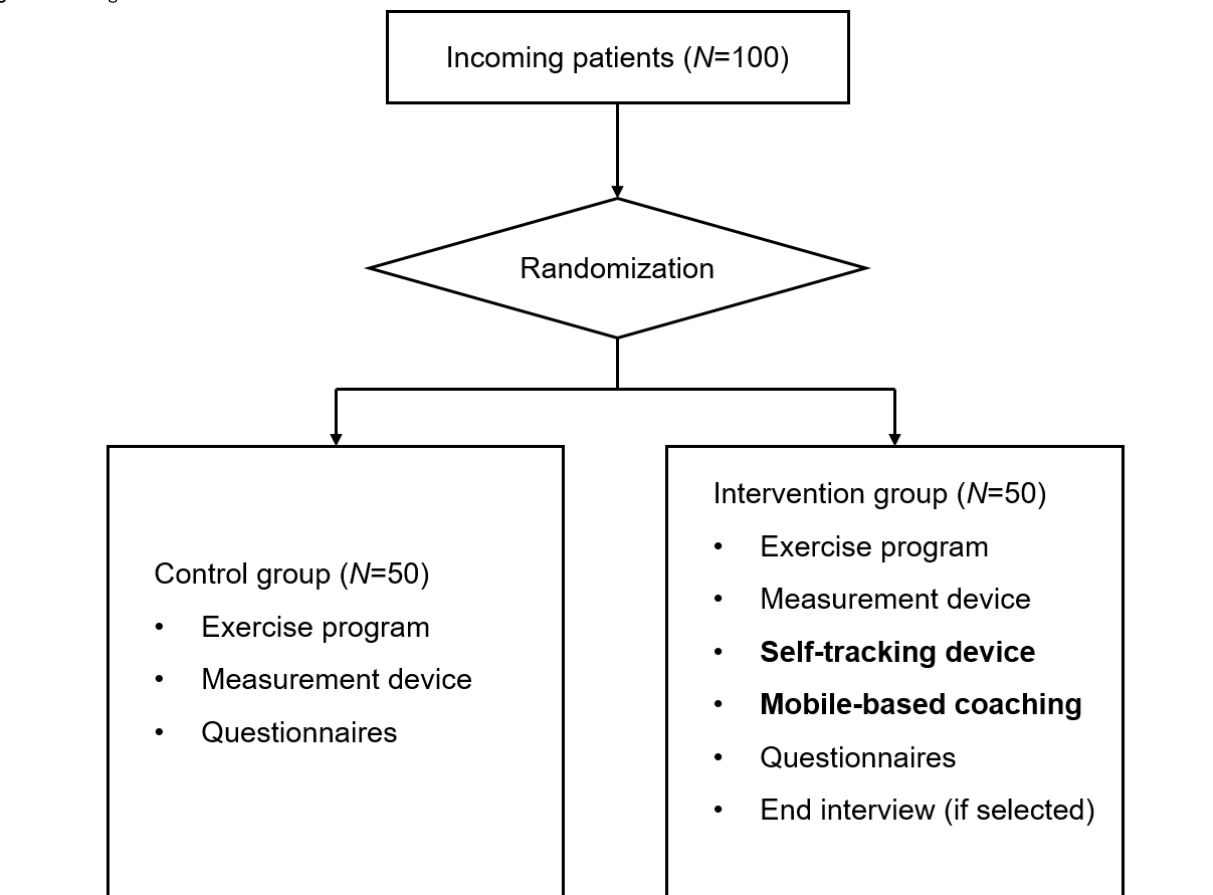
Figure 1. Design of the randomized controlled